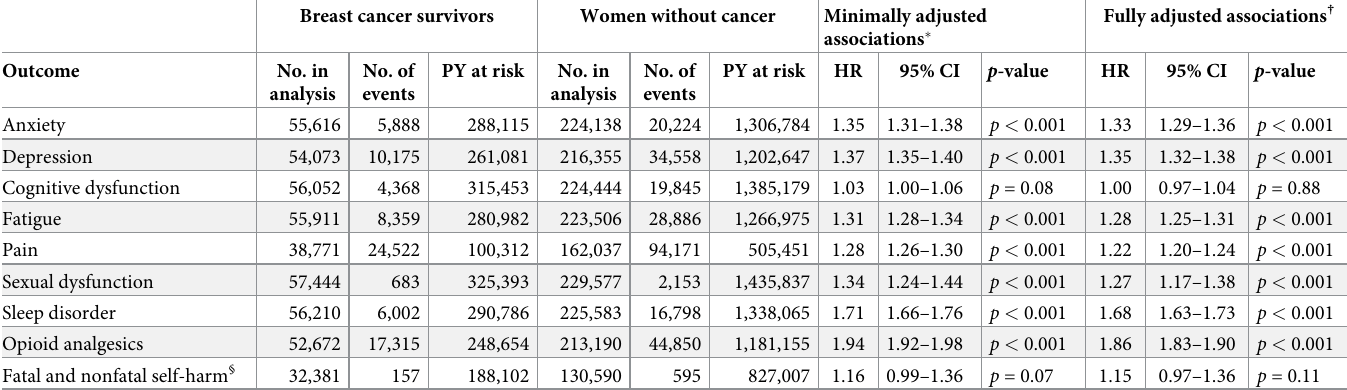
Table 2. Associations between breast cancer survivorship and adverse mental health outcomes, fatigue, and pain; women diagnosed with breast cancer in the UK between 1988 and 2018, compared to women who never had cancer.